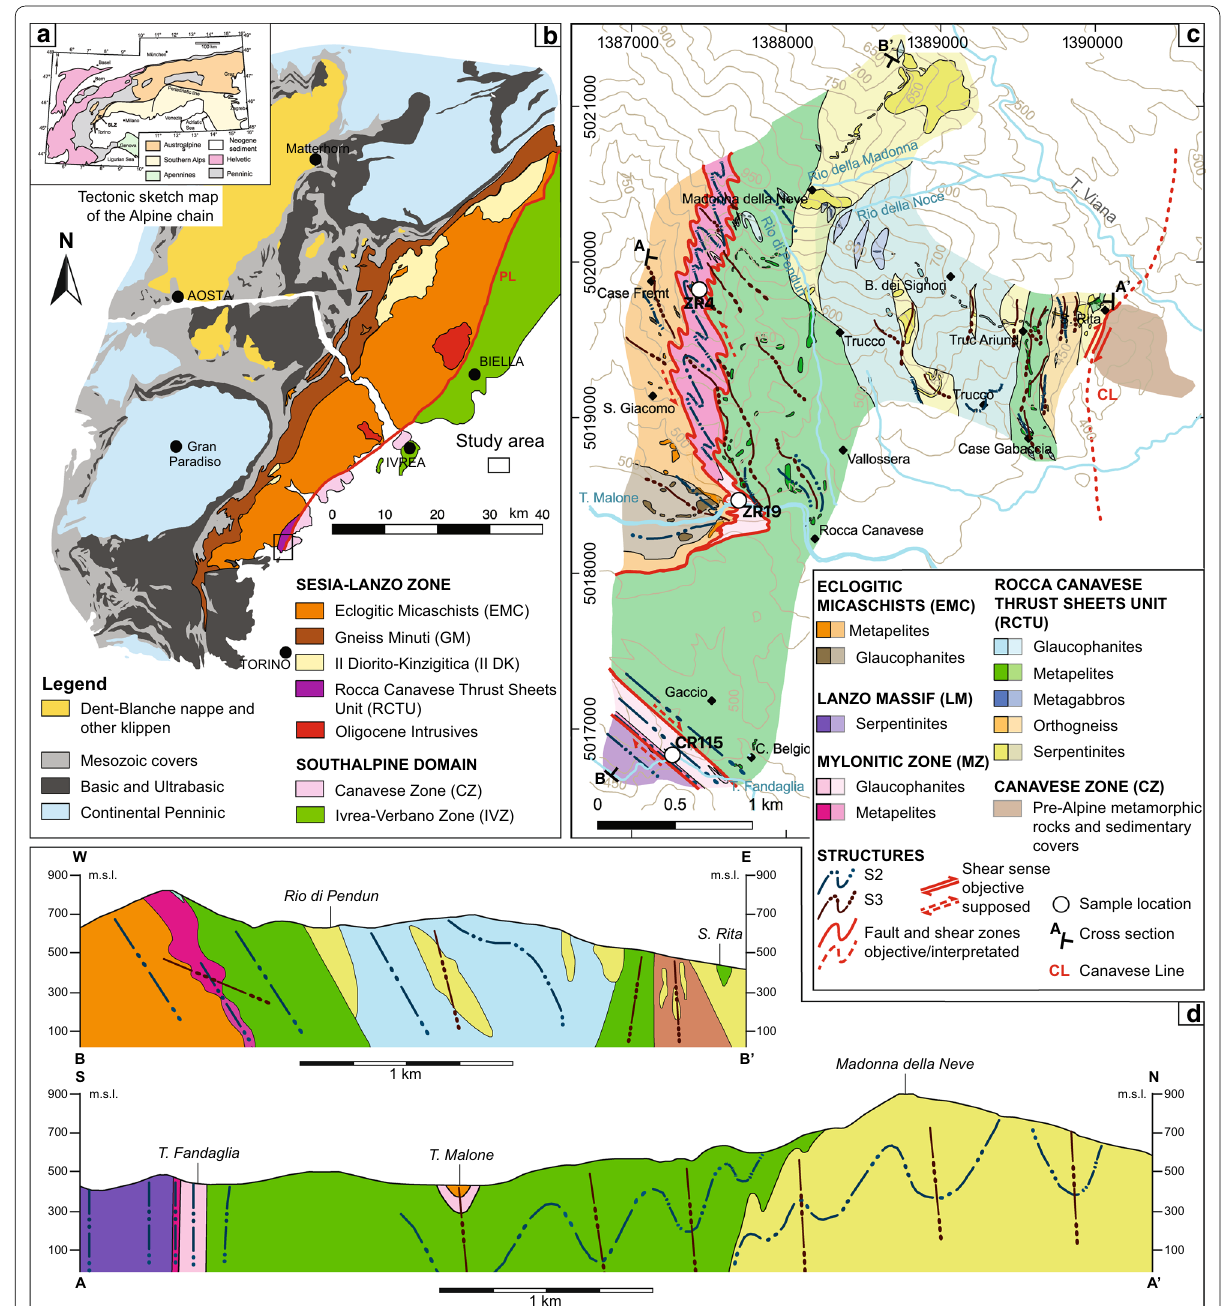
Fig. 1 a Tectonic sketch of the Italian Alps with the main structural domains. b Tectonic map of Western Alps with the boundaries of metamorphic complexes that constitute the Sesia–Lanzo Zone. PL Periadriatic Lineament. Black rectangle locates the investigated area. c Interpretative geological map of Rocca Canavese Thrust Sheets Unit (RCTU), the adjacent units Eclogitic Micaschist Complex (EMC), and the Lanzo Massif (LM). The location of sample used for the Q-XRMA analysis is reported (ZR4: x Coordinate system WGS 84-UTM 32 N. Redrawn after Cantù et al. 2016 and Roda et al. 2018. d Geological cross-sections (see traces in the geological map). Redrawn after Cantù et al. (2016) and Roda et al.